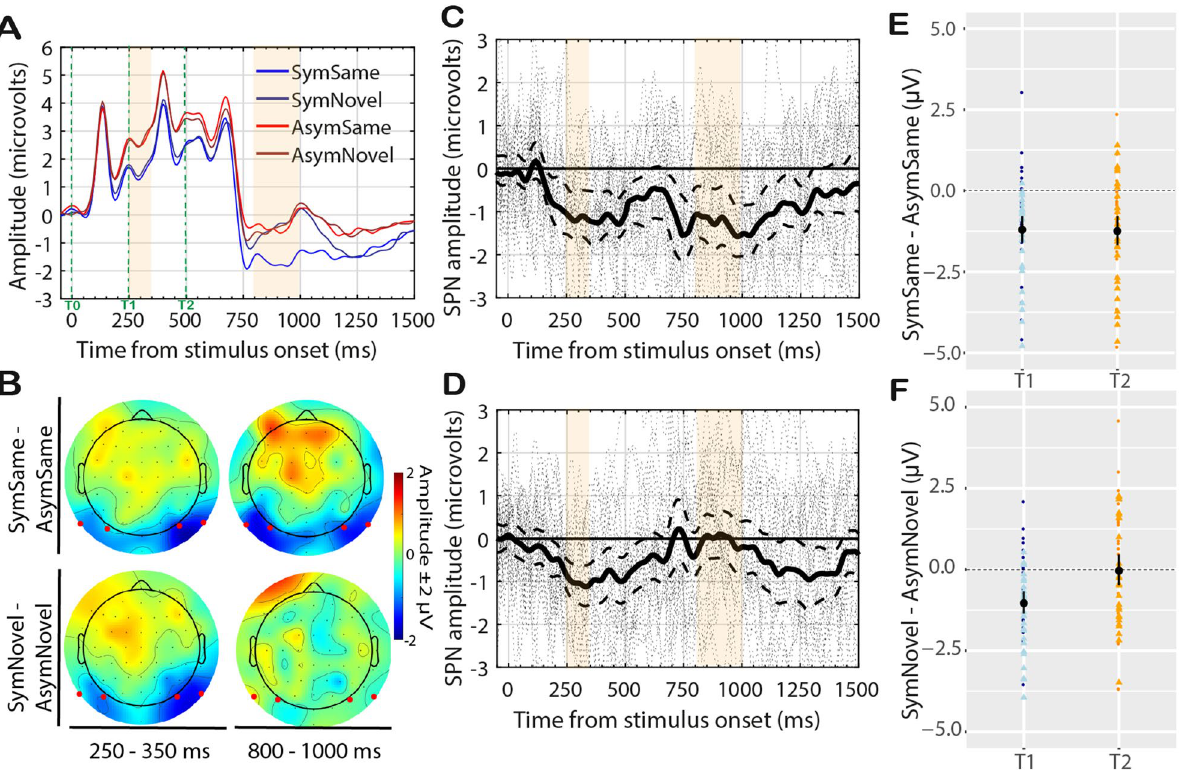
Figure 3. Experiment 1 results. ( A ) Grand average ERPs averaged from electrode cluster P9 PO7 P10 PO8. A SPN is observed after ~ 200 ms from T0. Then SPN emerges again ~ 250 ms from T2, only for the SymmetrySame condition. The orange regions indicate the time-windows used for the analysis. ( B ) Topographic difference maps (Symmetry–Asymmetry) for the time-window 350–350 ms and 800–1000 ms from T2. Red dots indicate electrodes analysed. ( C ) The SPN (difference wave) for SymmetrySame – AsymmetrySame and ( D ) the SPN for SymmetryNovel – AsymmetryNovel . Solid line is shown along with 95% confidence intervals (C.I.; thick dashed lines) and individual-subject responses (thin dashed lines). When C.I. are below zero, the difference wave is significant at the 0.05 level. ( E ) Stripchart (i.e., one- dimensional scatter-dot plots) showing distributions of individual difference amplitudes for SymmetrySame – AsymmetrySame and ( F ) SymmetryNovel – AsymmetryNovel at the two timewindows. Dark-coloured dots represent responses at the left hemisphere; light- coloured triangles represent responses at right hemisphere. Mean difference amplitude is superimposed (black dot), and error bars indicate 95%